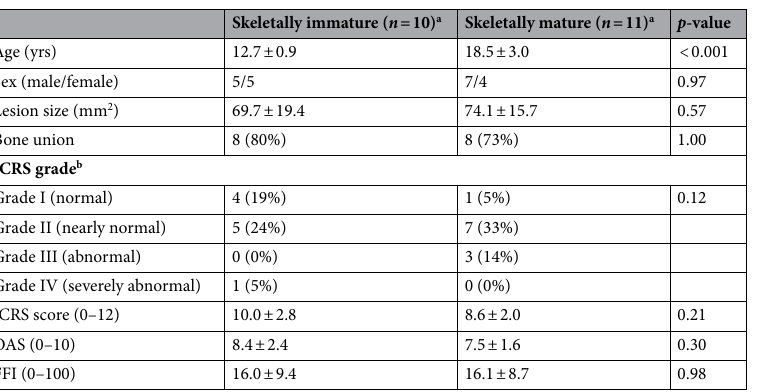
Table 2. Comparison of secondary arthroscopic findings between patients with skeletally immature and mature ankle. Skeletal maturity was determined by whether the growth plate of the distal tibia was opened or closed. a Values are given as the mean ± standard deviation, with the exception of sex, bone union and ICRS grade. b Values are given as the number and the percentage in parenthesis. ICRS International Cartilage Repair Society, OAS Oswestry Arthroscopy Score, FFI Foot Function Index.